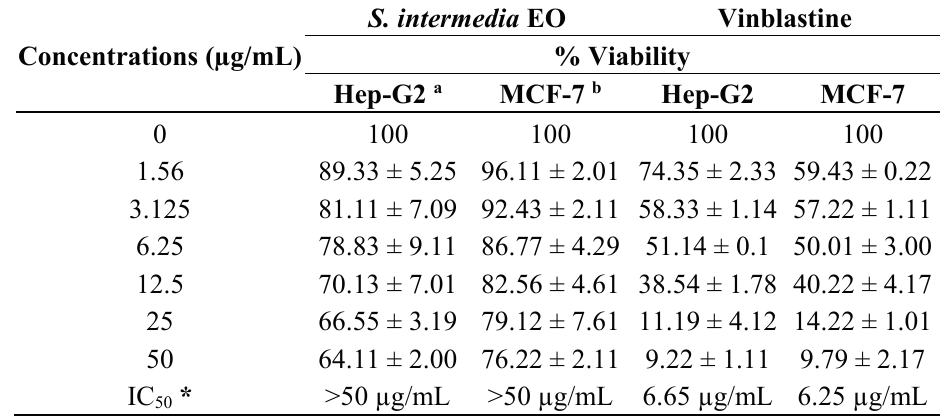
Table 2. Cytotoxic activity of Satureja intermedia C.A.Mey EO on human cancer cell lines.